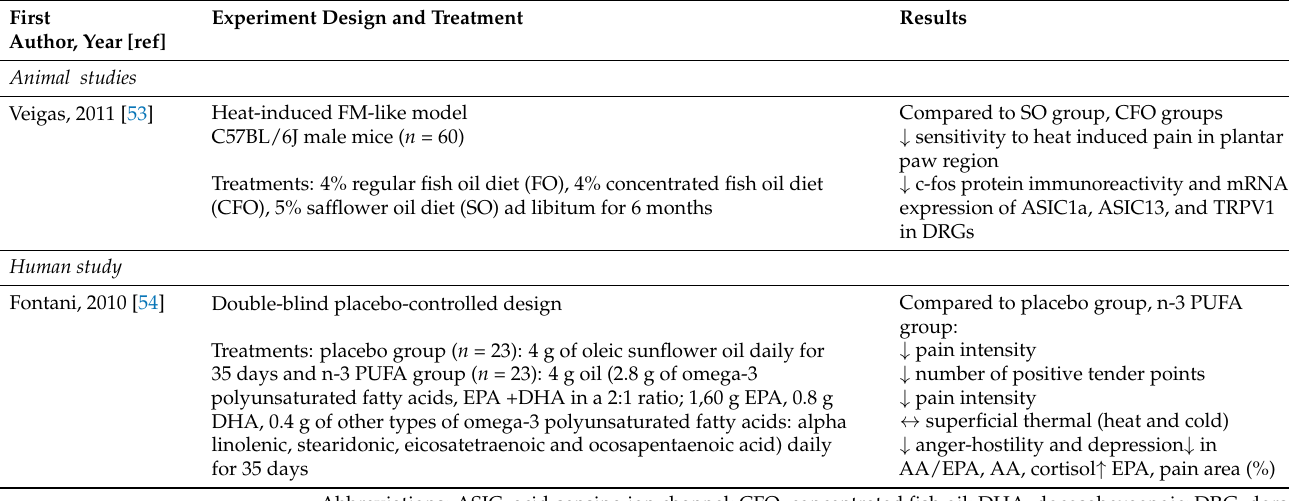
Table 5. Effects of omega-3 PUFAs on fibromyalgia-like